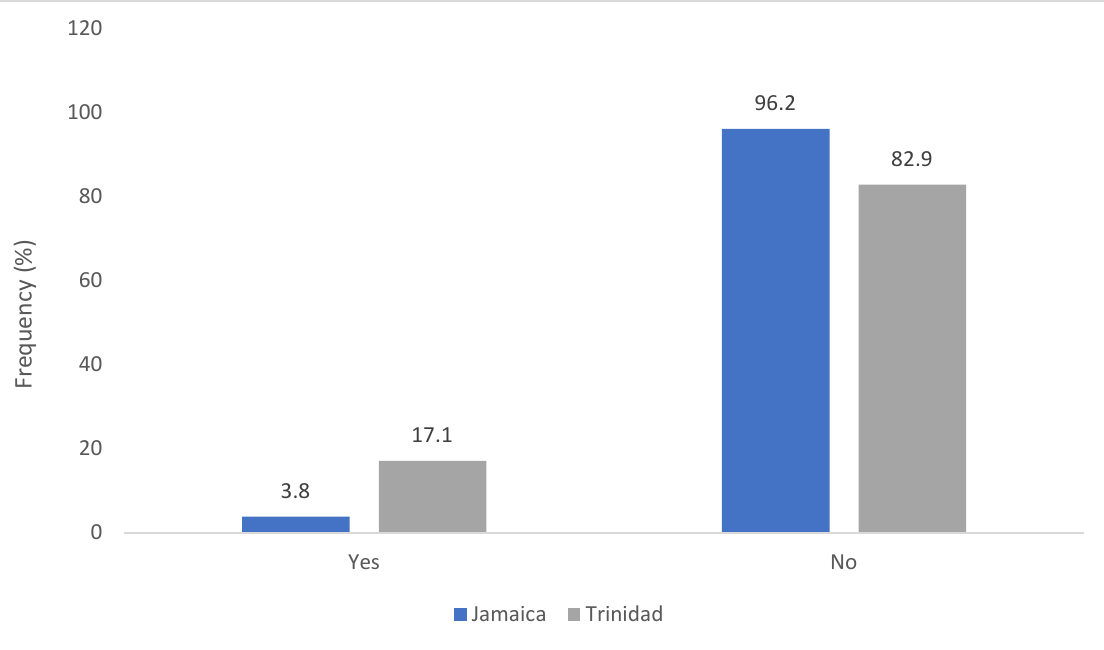
Figure 5. The presence of written antibiotic policies in clinics of Jamaica vs. Trinidad .